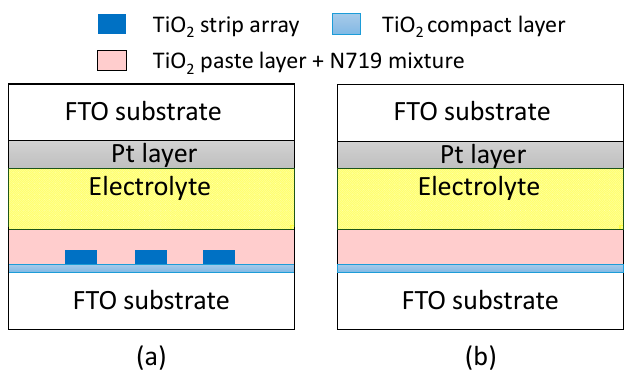
Figure 2. Schematic configuration of DSSCs ( a ) with and ( b ) without TiO 2 strip array.